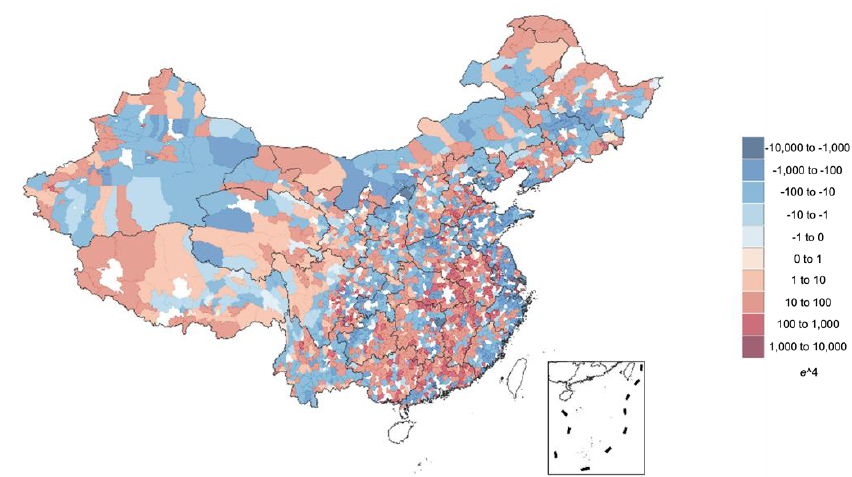
county boundaries. Blue crosses denote center coordinates that fall into the boundary of Liping County, while red points denote centers that do not.